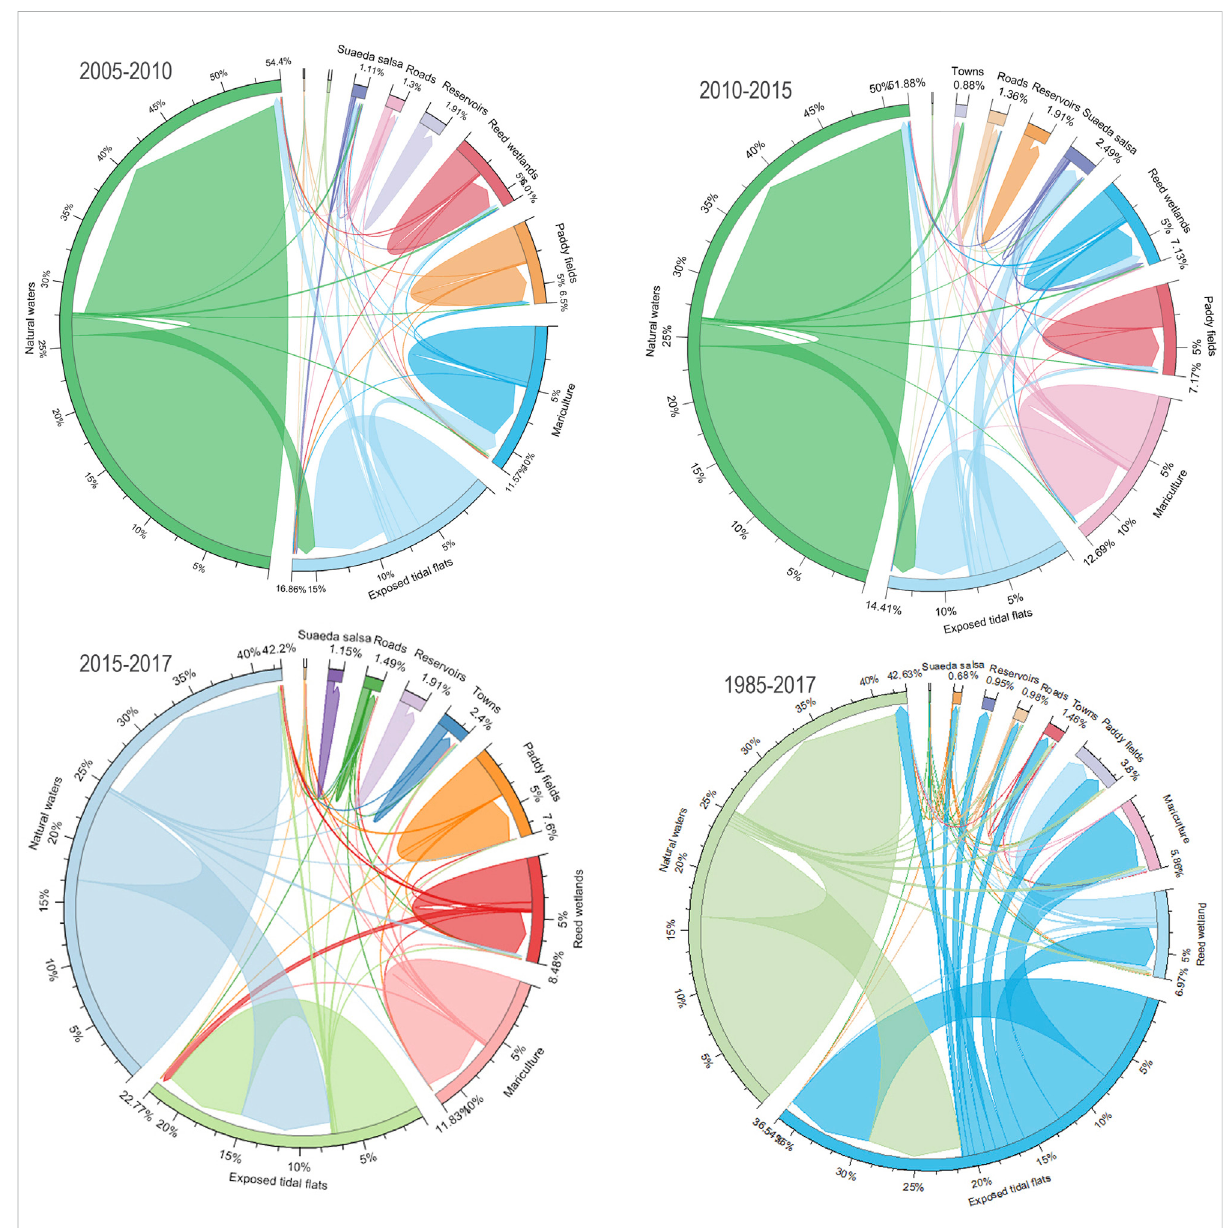
To analyze the spatial and temporal distribution differences of the ERI , the values of ERI were divided into low ecological risk areas, medium ecological risk areas, and high ecological risk areas using the Jenks natural breaks classi fi cation method (Chen et al., 2013; Gong et al., 2021). Then, the spatial distribution characteristics of the ERI were analyzed using the kriging interpolation method, and the spatial distribution changes of the number of high-risk, medium-risk, and low-risk grids were statistically